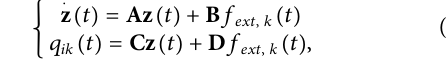
Frontiers in Energy Research |